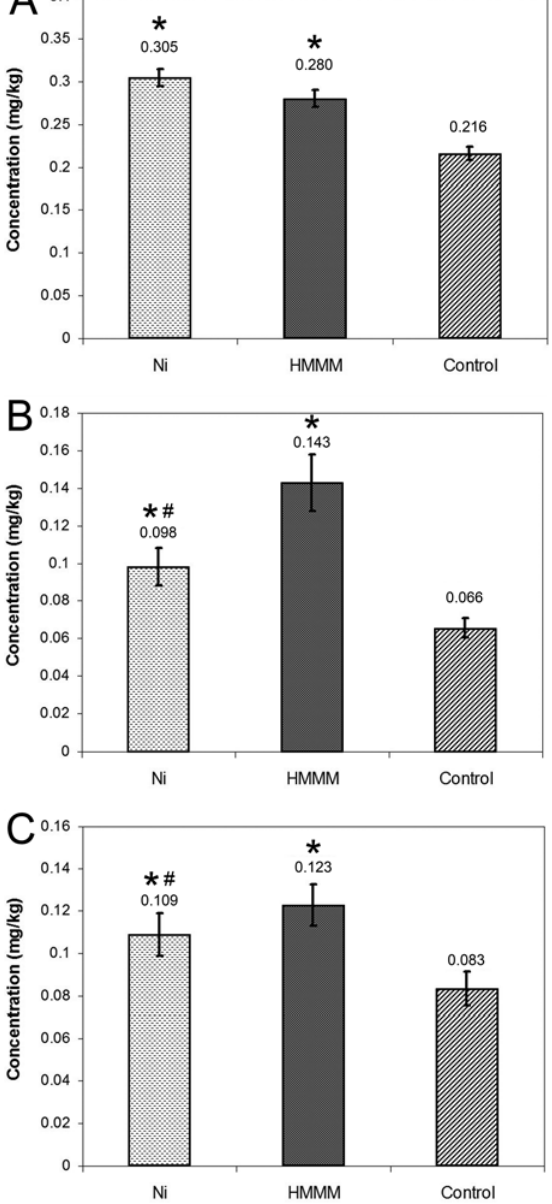
Fig. 3. Comparison of Ni concentration in Ni-exposed (Ni) and mixture-exposed (HMMM) Gibel carp body tissues: muscle (A), gills (B) and liver (C) (Mean±SD). Asterisks (*) denote values significantly different from control, and grades (#) denote significant differences between Ni and mixture-exposed fish at p ≤ 0.05,